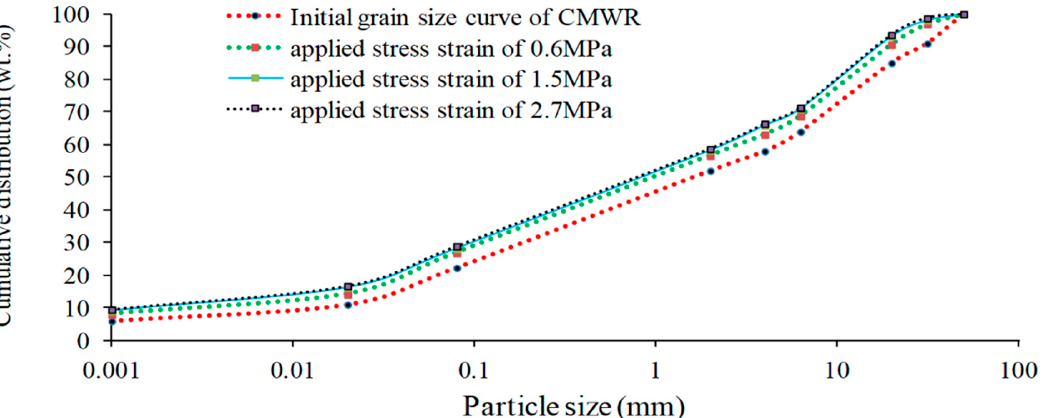
Figure 7. Evolution of grading curves of CMWR under controlled compaction energies.